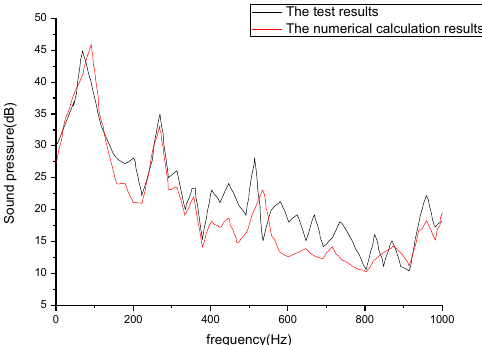
Figure 1. The comparison curve between the experimental test and numerical simulation. The dark line shows the results of the preliminary test, and the red line shows the results of the numerical calculation. The horizontal axis denotes the frequency in the range from 0 to 1000 Hz, and the longitudinal axis indicates the sound pressure level with the reference of 20 u Pa.